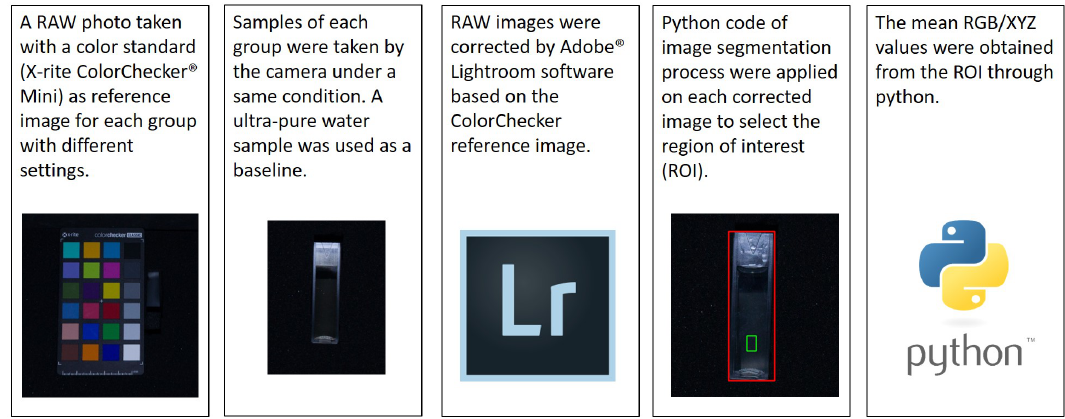
Figure 2. Image correction process by using a color standard (X-rite ColorChecker ® Mini) and color space